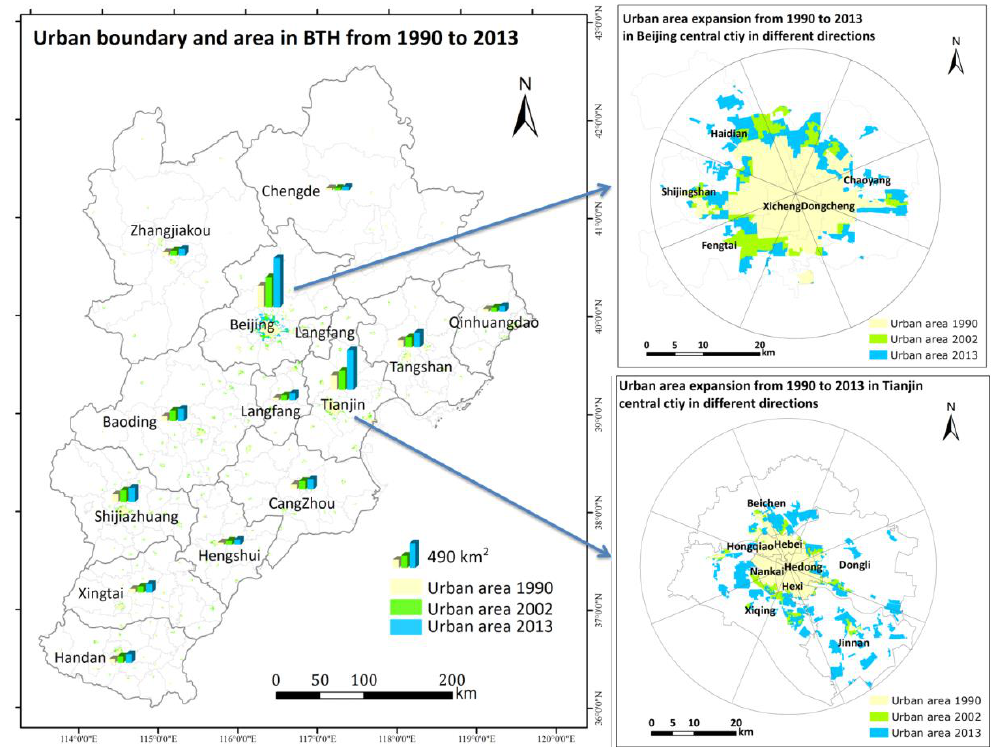
Figure 6. Urban area expansions from 1990 to 2013 in BTH.